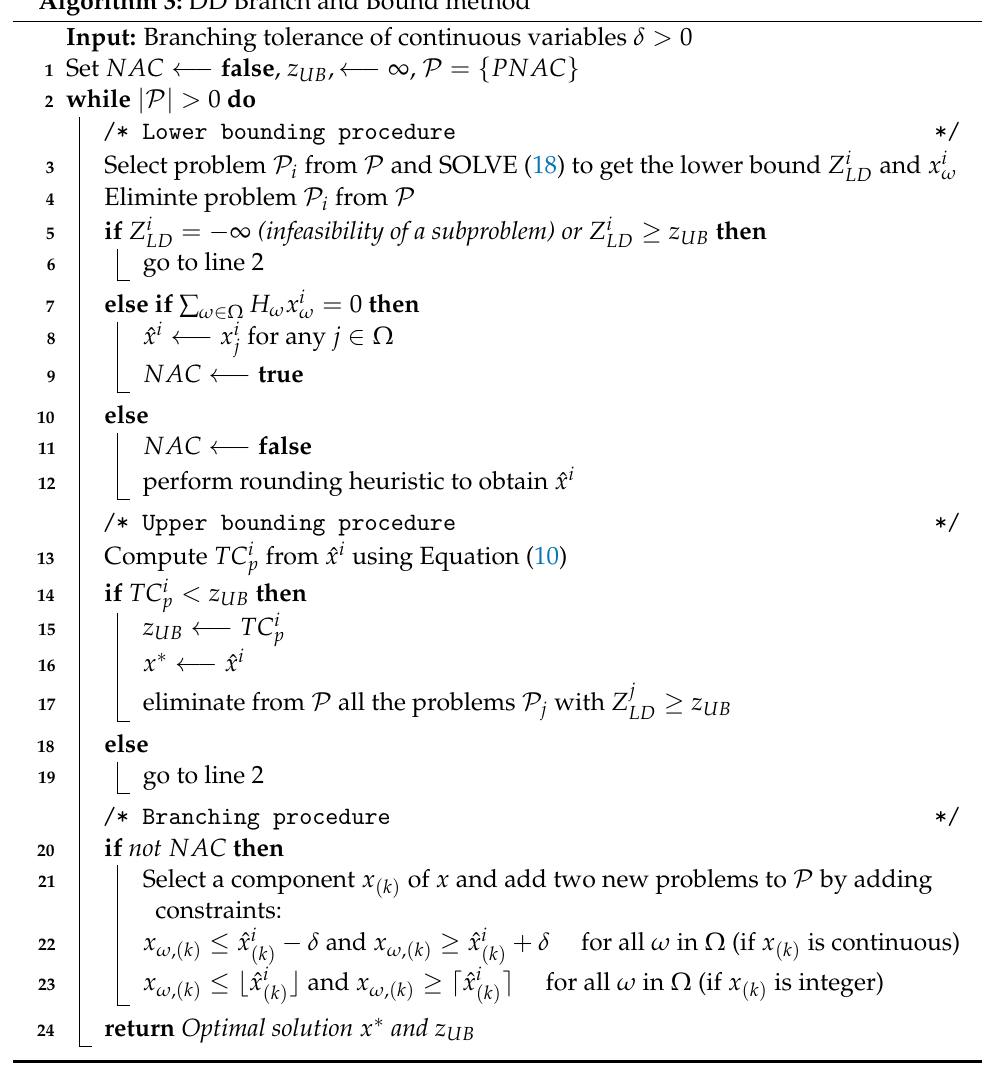
Algorithm 3: DD Branch and Bound